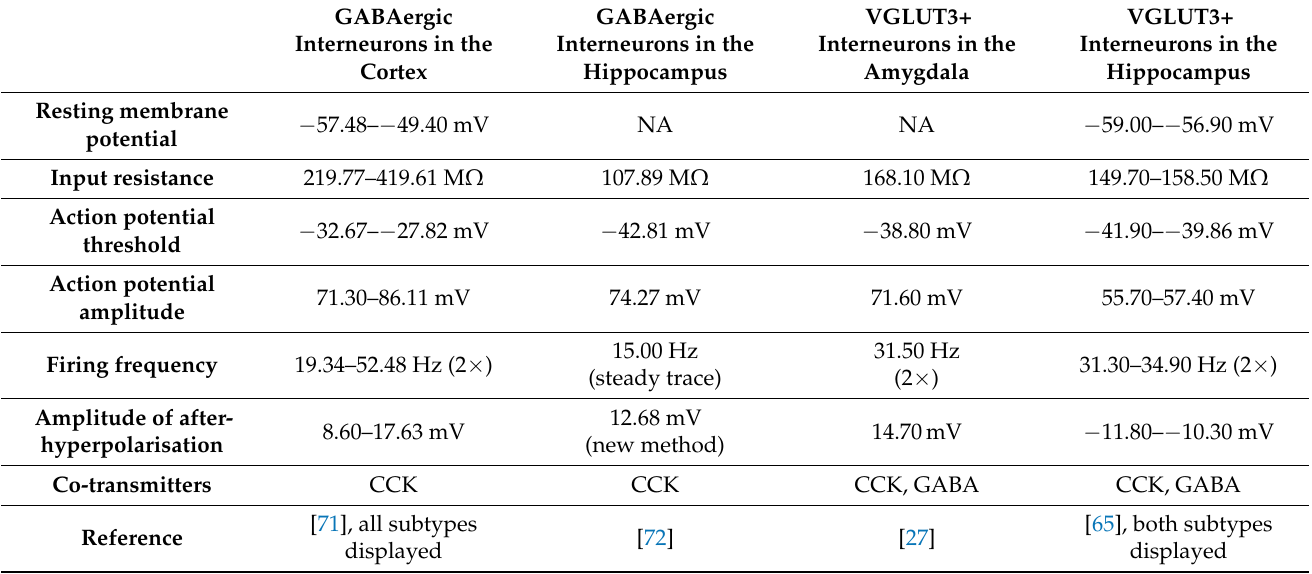
Table 1. Electrophysiological characteristics of different VGLUT3 containing and non-containing interneurons in the central nervous